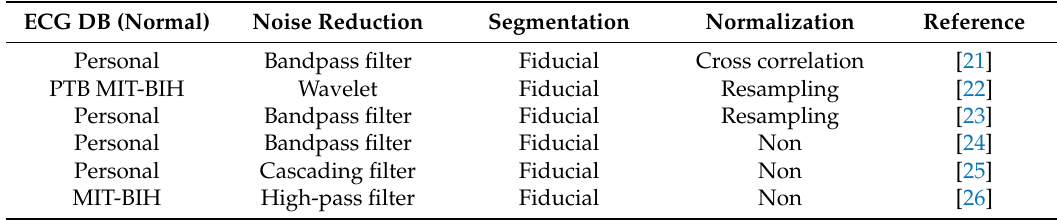
Table 1. Preprocessing in the normal state for normalization.